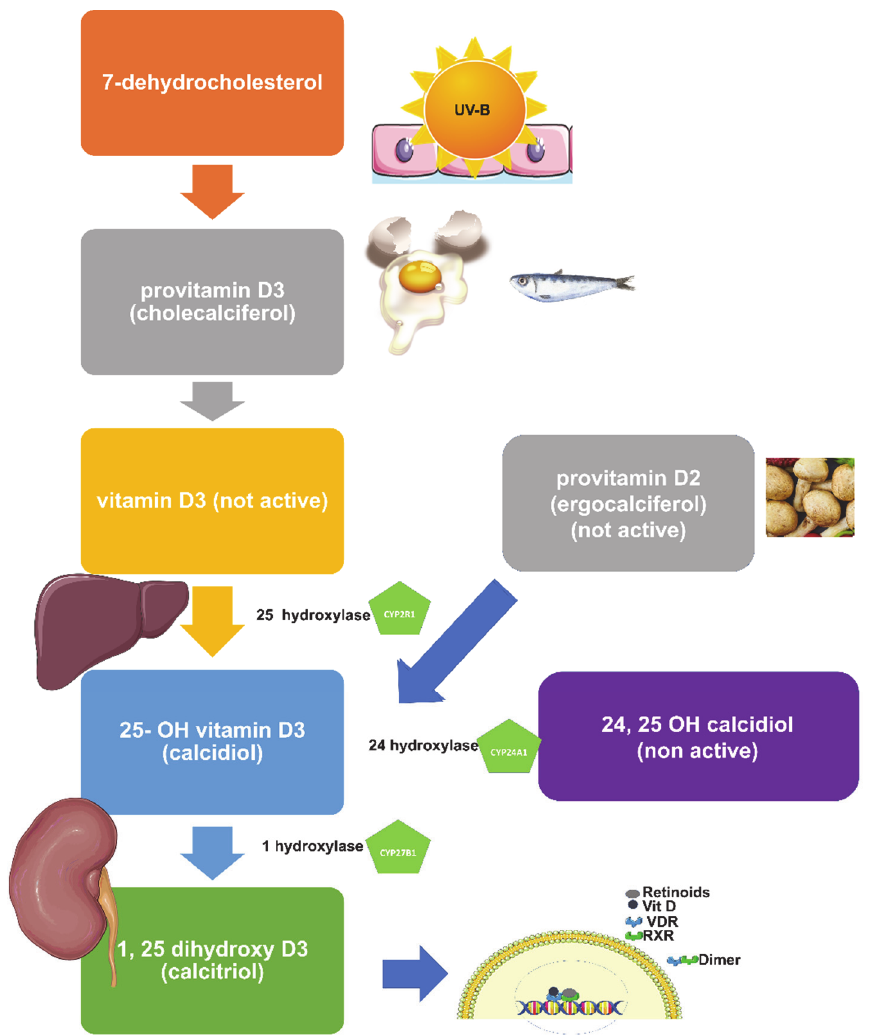
Figure 2. Metabolic steps of vitamin D.